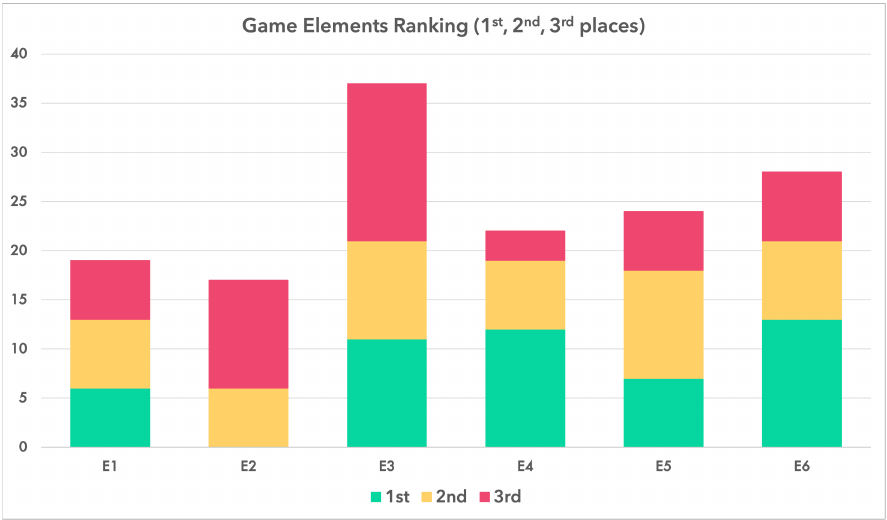
Figure 7. Distribution of the first three positions in the ranking of the most distracting game elements.